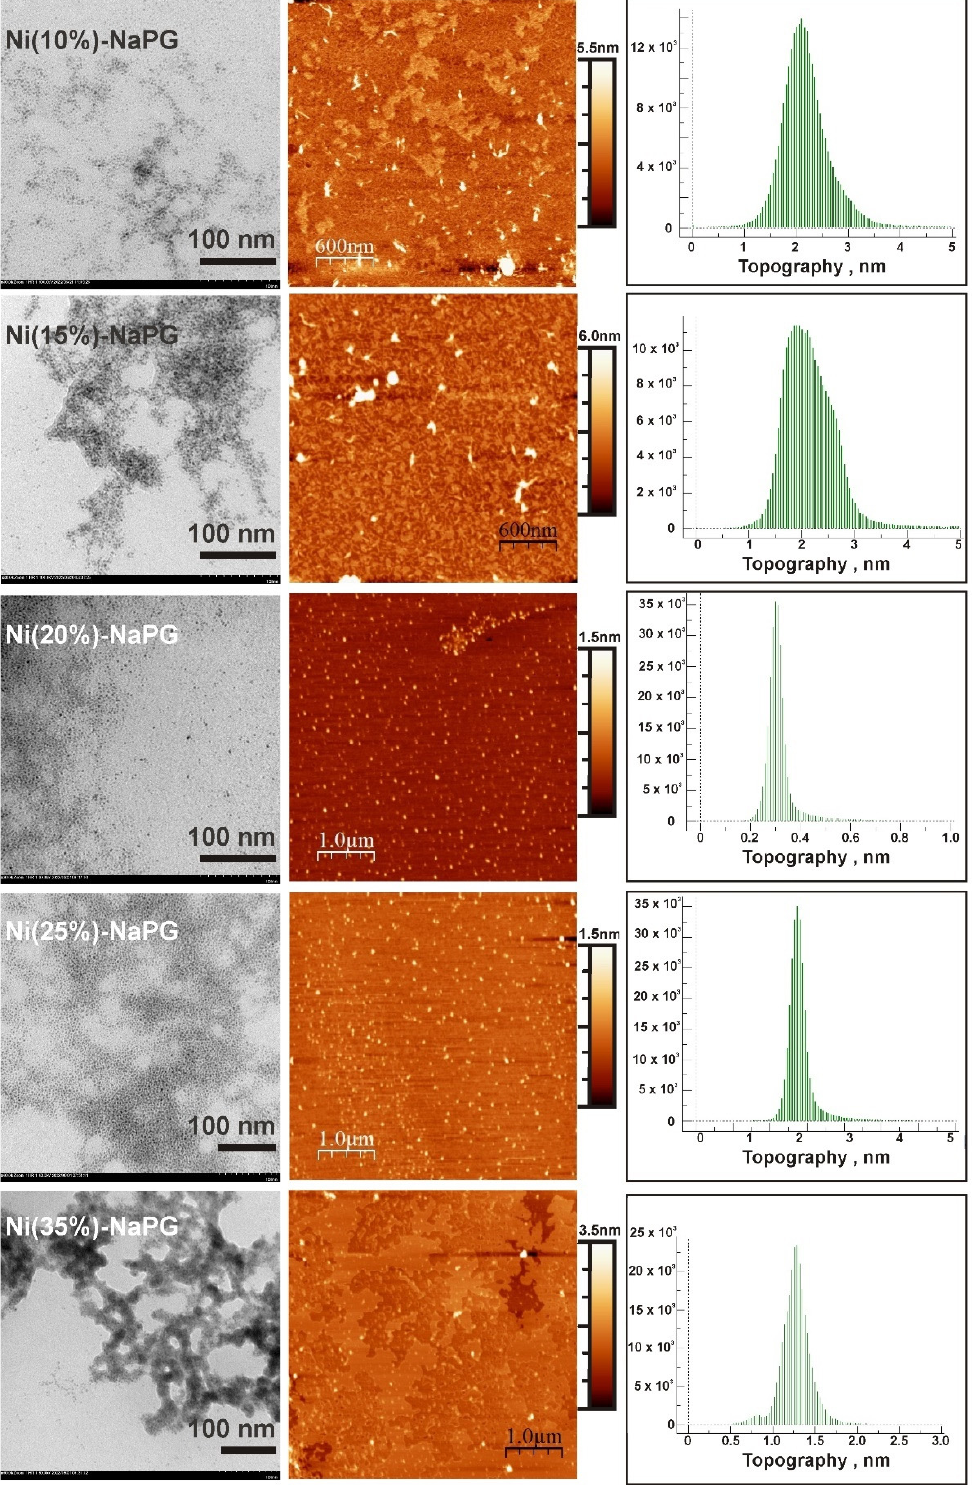
Figure 2. TEM images ( left column ), AFM images ( central column ) and particle size distribution ( right column ) from the AFM images for the Ni(n%)-NaPG compounds indicated in the left column.